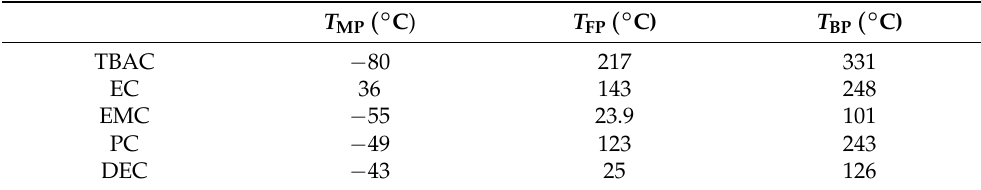
Table 2. Physical properties of TBAC [24], EC [28], EMC [4], PC [29], and DEC [5]. Symbols used: T MP , melting point; T FP , flash point; T BP , boiling